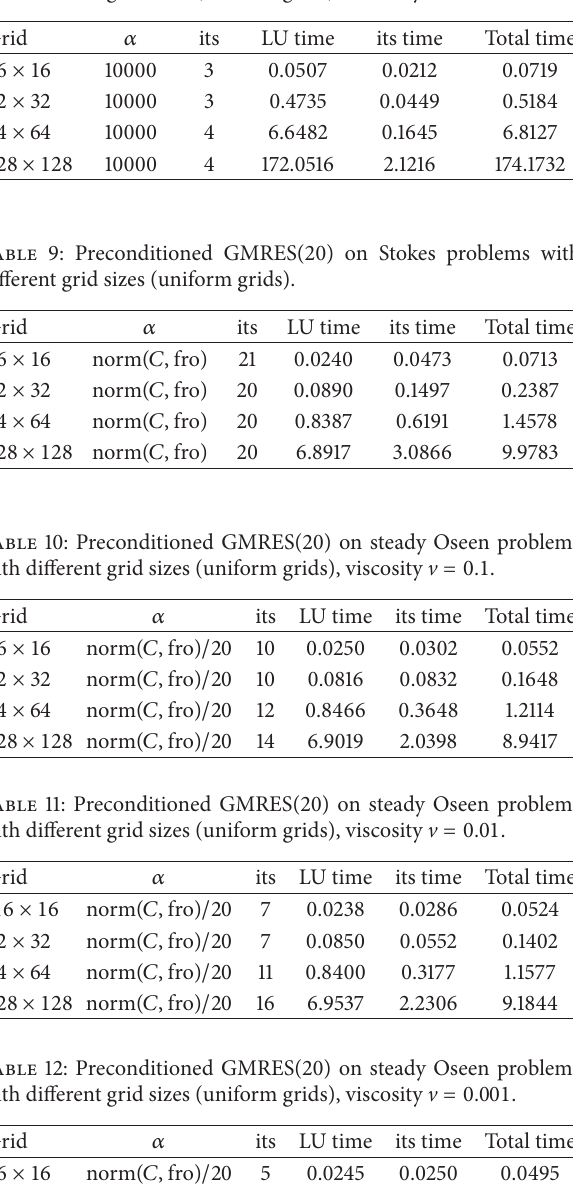
Table 8: Preconditioned GMRES(20) on steady Oseen problems with different grid sizes (uniform grids), viscosity V = 0.001 .